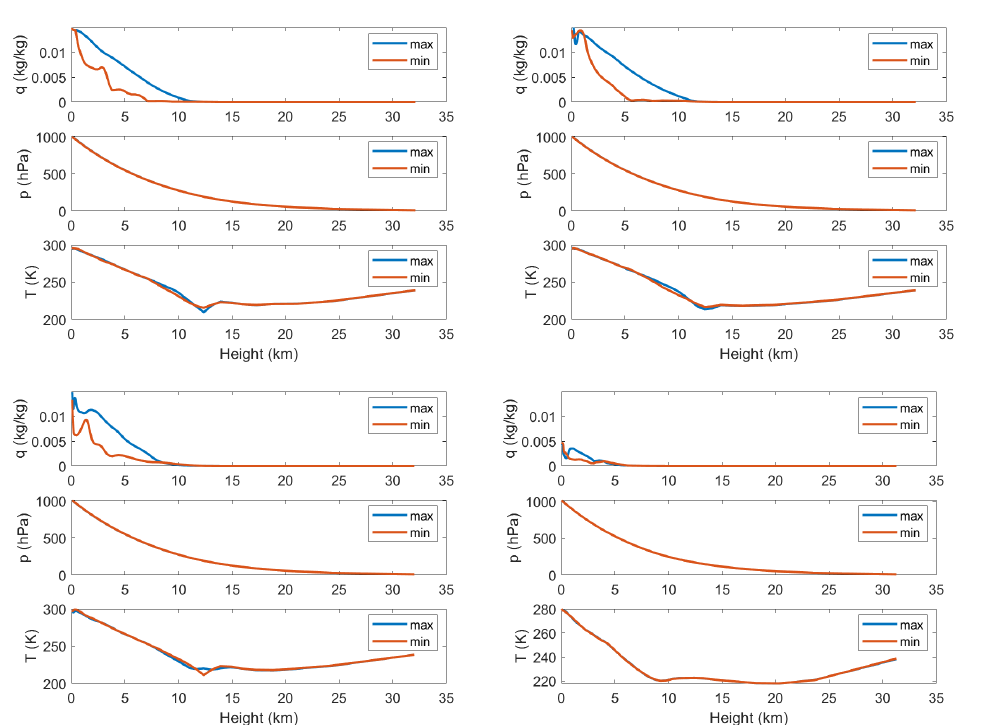
Figure 8. Specific humidity q , pressure p , and temperature T as functions of height for the three pixels with the highest dZTD values, and a pixel with no events (lower right).